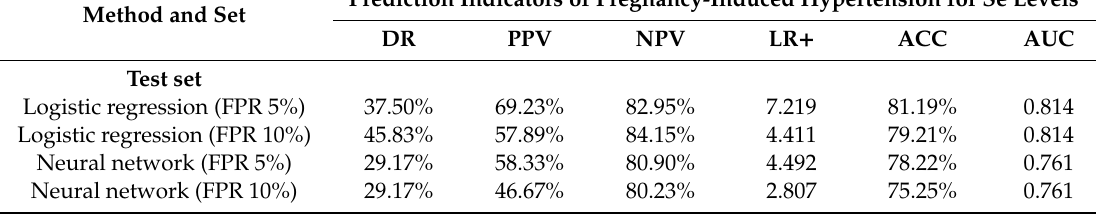
Table 4. Prediction indicators of pregnancy-induced hypertension for Se levels in serum in the 10–14th gestational week in test sets of logistic regression and neural